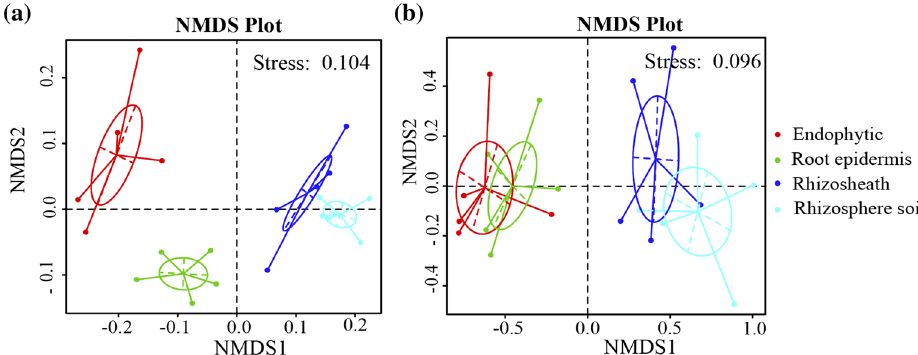
Figure 5. NMDS analysis of bacteria and fungi. In ( a ) and ( b ) refer to the NMDS analysis of bacteria and fungi samples, respectively. Each point in the figure represents a sample. The distance between points indicates the degree of difference, and samples from the same group are represented by the same color and connected by lines and ellipses. When stress is less than 0.2, NMDS can accurately reflect the difference between sample groups.